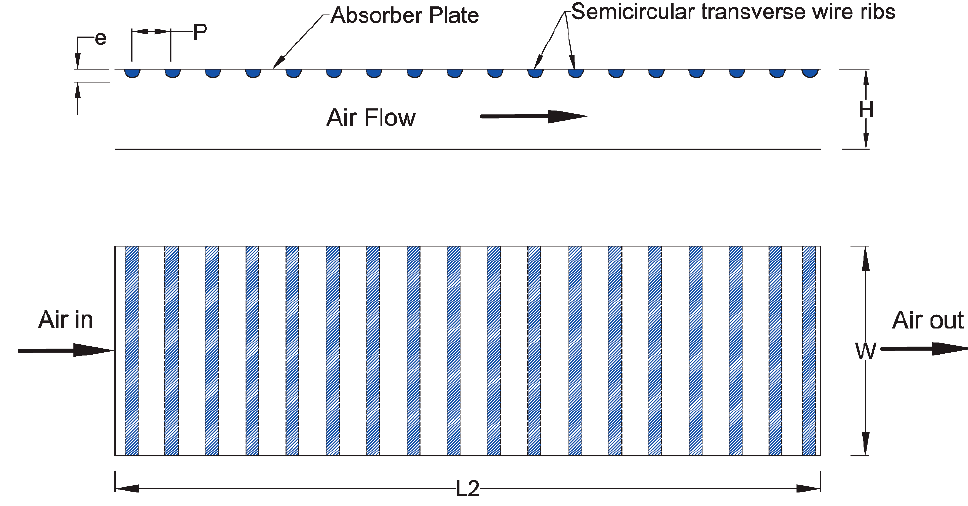
Figure 2. Absorber plate with ribs. Table 2. Values of operating parameters for numerical